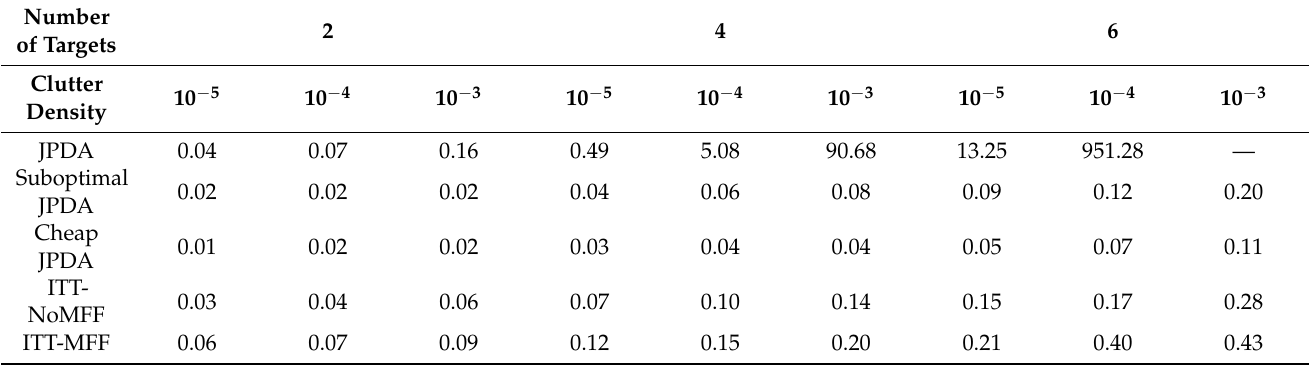
Table 5. Running time comparisons (unit: s).